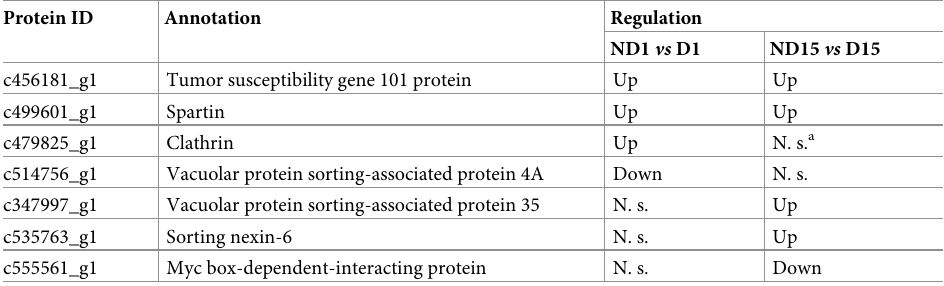
Table 3. DAPs involved with endocytosis in ND vs D comparisons based on KEGG analysis.